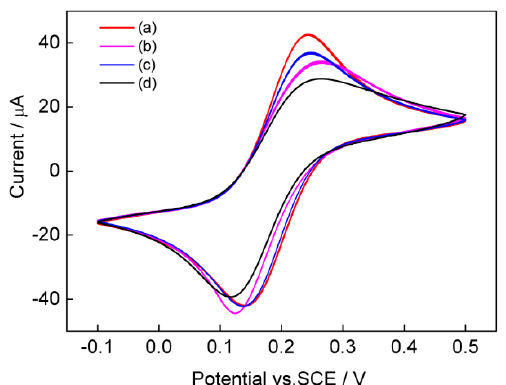
Figure 4. Cyclic voltammograms of the ( a ) bare Au electrode; ( b ) sol-SWCNTs/Au; ( c ) sol-SWCNTs-AuNRs/Au; and ( d ) sol-SWCNTs-AuNRs-GOD/Au in 0.1 M KCl containing 5 mM [Fe (CN) 6 ] 3 − /4 − (1:1) with a scan rate of 50 mV/s.